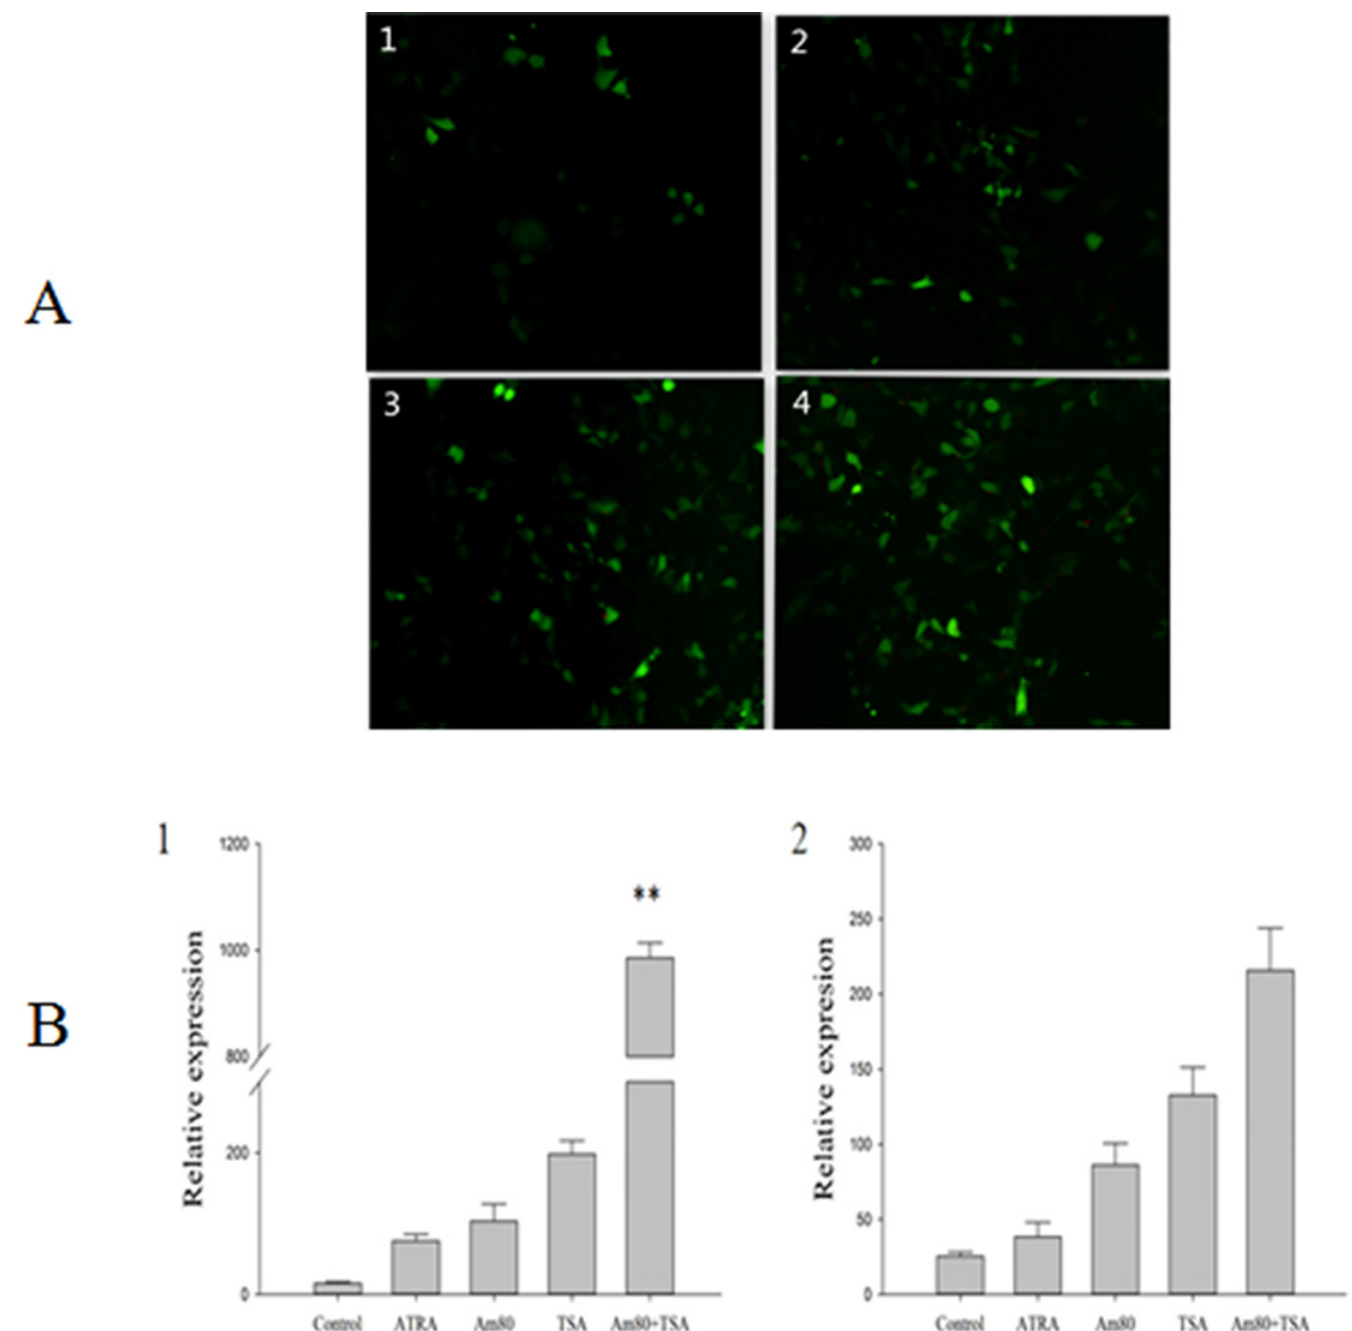
Fig 4. The regulatory function of Am80 and TSA induction on the expression of Stra8 . A: 1. ATRA induction group; 2. Am80 induction group; 3. TSA induction group; 4. Am80 and TSA combination induction group. B: 1: Stra8 ; 2: Scp3. ** P <